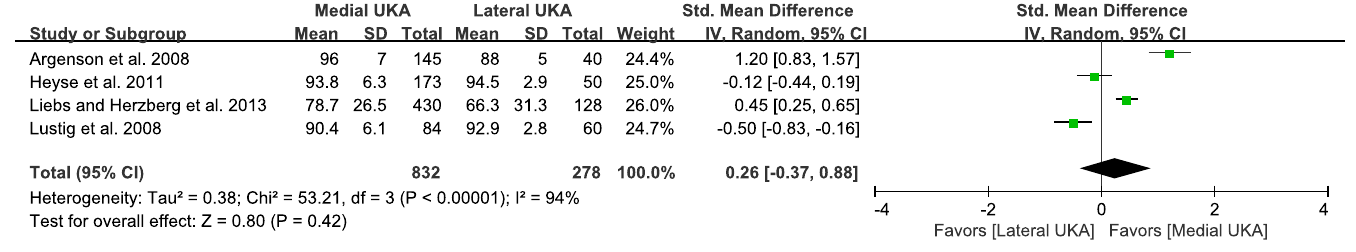
Fig 3. Results of aggregate analysis for comparison of pain scores between patients with medial and lateral